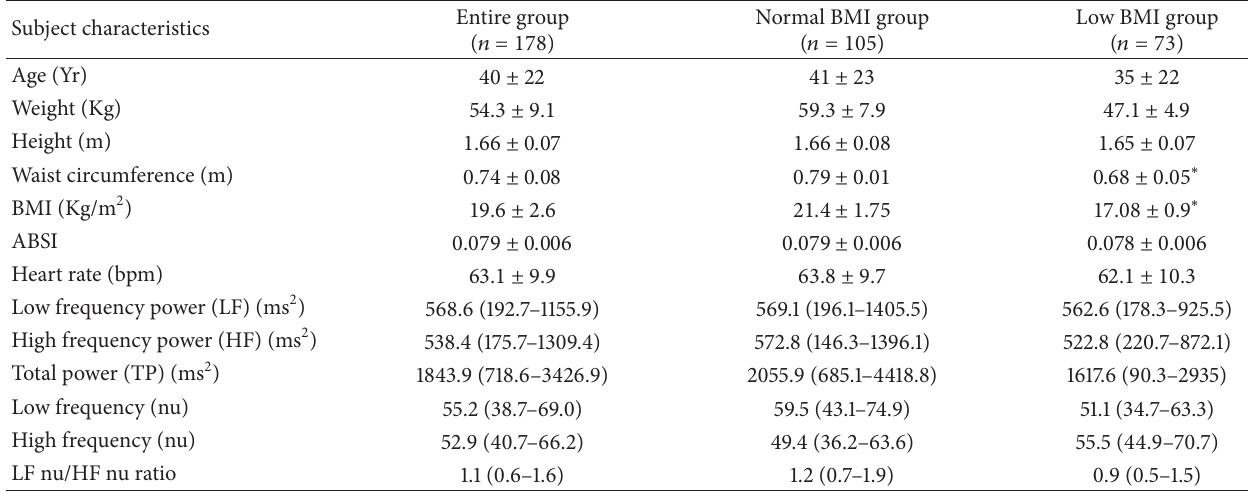
Table 1: Descriptive characteristics of study population.